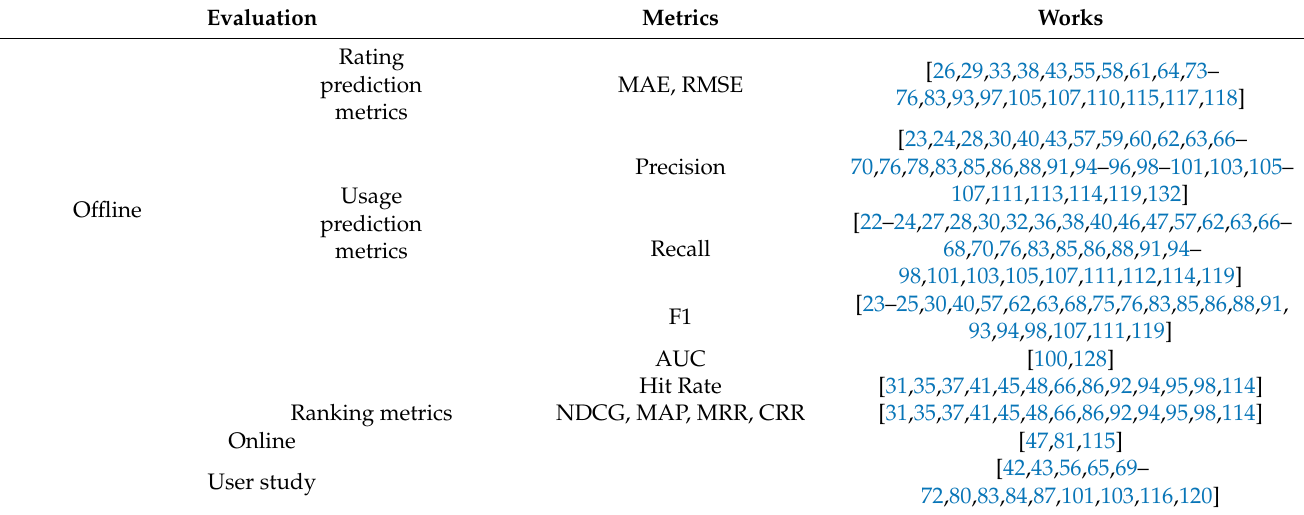
Table 5. Evaluation protocols and metrics employed in the included works.